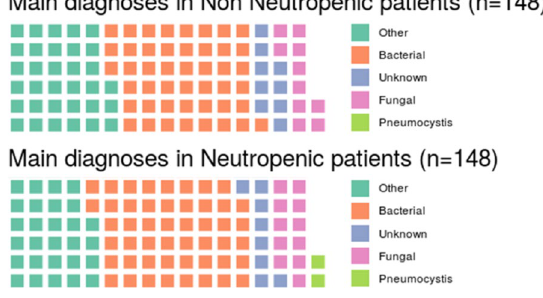
Fig. 1 Main diagnoses according to neutropenia in the matched